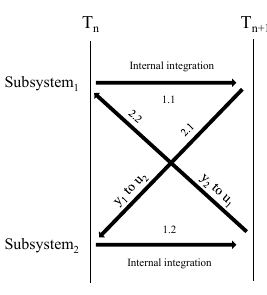
Figure 2: Waveform Re- laxation iteration. In- tegration of one subsys- tem from time T n to T n +1 is completely inde- pendent. The numeri- cal solver of a subsystem, its internal step size or any other related informa- tion is completely isolated from outer working of the